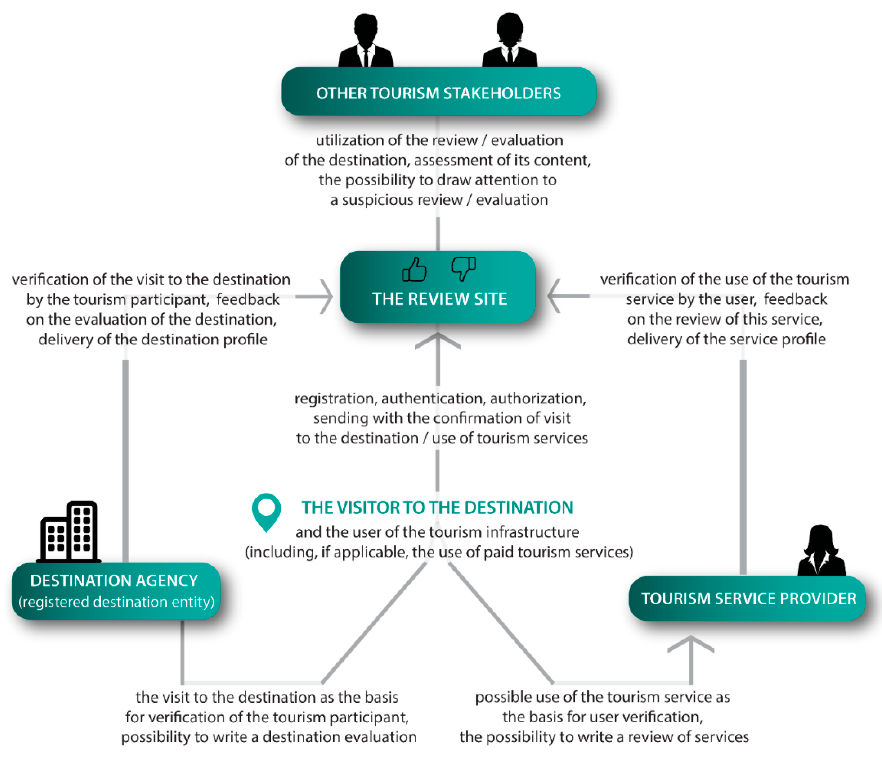
Figure 4. Conceptual model of providing a verified review of tourism services, or verified destination assessment.